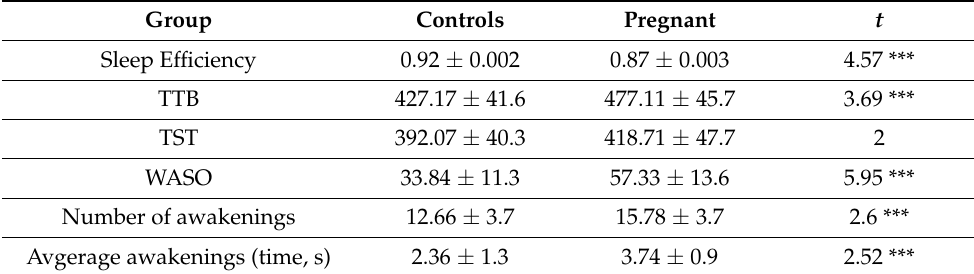
Table 2. Actigraphy parameters of pregnant women and non-pregnant controls. Group Controls Pregnant Sleep